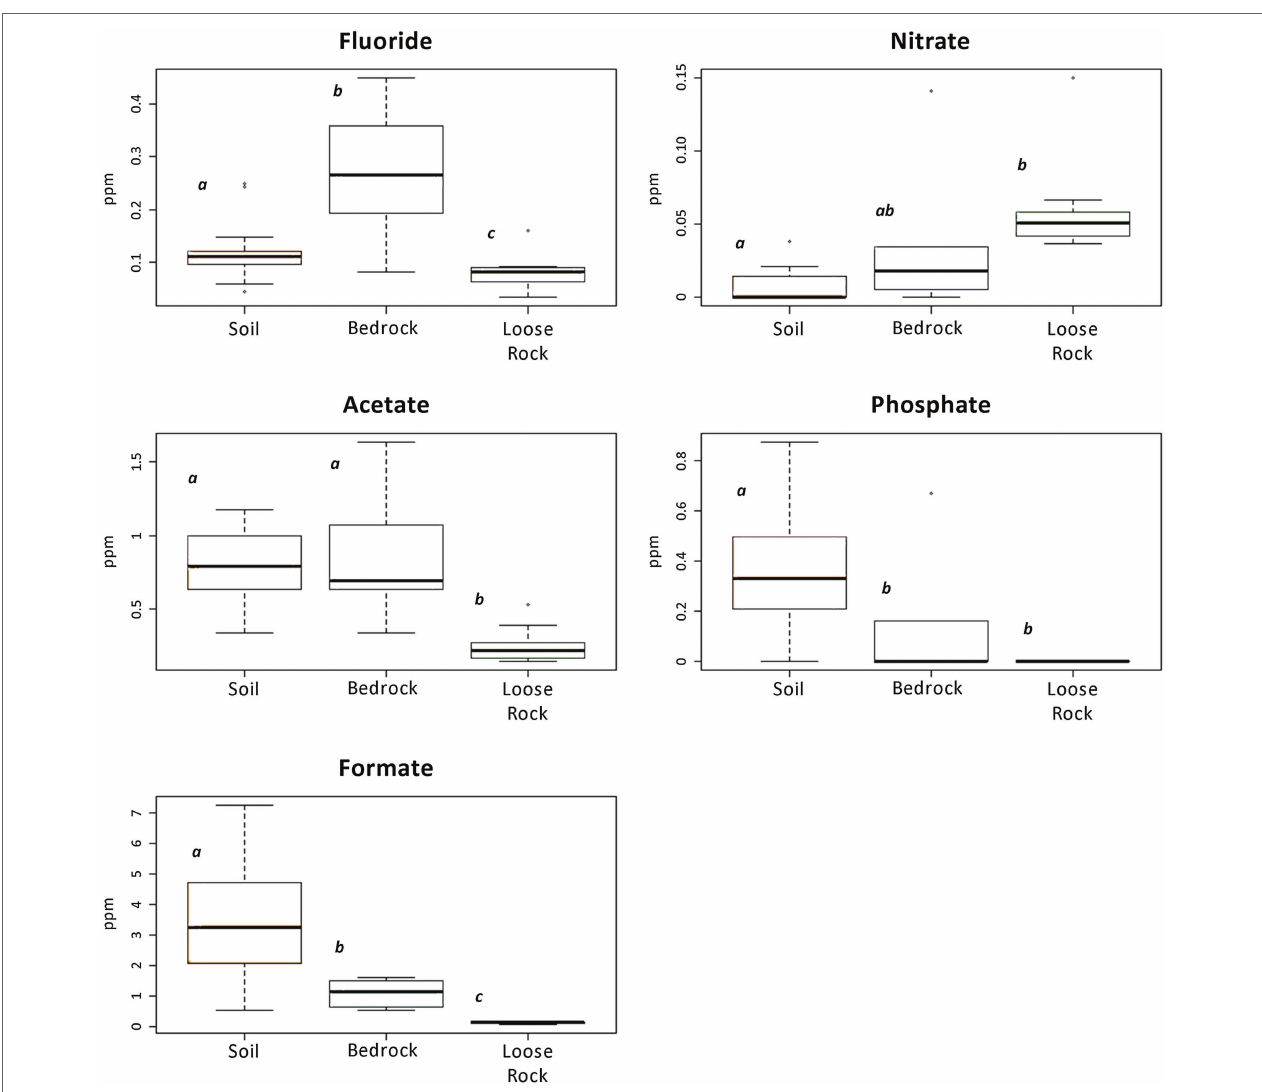
FIGURE 2 | Boxplots presenting ions and organic acids detected by Ion chromatography (IC) analysis that showed any significant difference among the analyzed substrates. Different letters depict significant differences ( p < 0.05) among the substrates. Note the difference in vertical axes